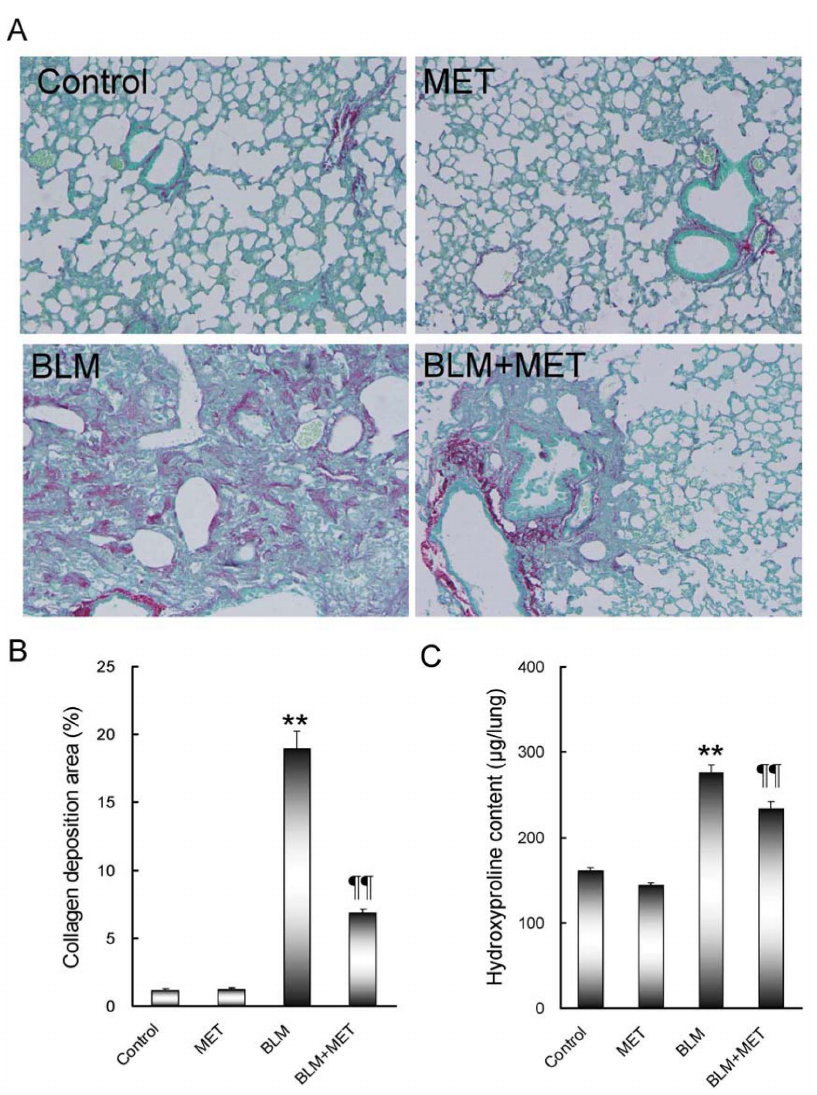
Figure 2. The effects of melatonin on BLM-induced pulmonary fibrosis. All mice except controls were intratracheally injected with BLM (5.0 mg/kg). In BLM + melatonin group, mice were i.p. injected with melatonin (5 mg/kg) daily. Lungs were collected at 21 days after BLM. (A) Lung fibrosis was evaluated by Sirius red staining. Original magnification: 100 6 . (B) Collagen deposition areas were quantified. (C) Hydroxyproline content in the lungs was analyzed. All data were expressed as means 6 SEM (n=12). ** P , 0.01 as compared with control group. `` P , 0.01 as compared with BLM group.